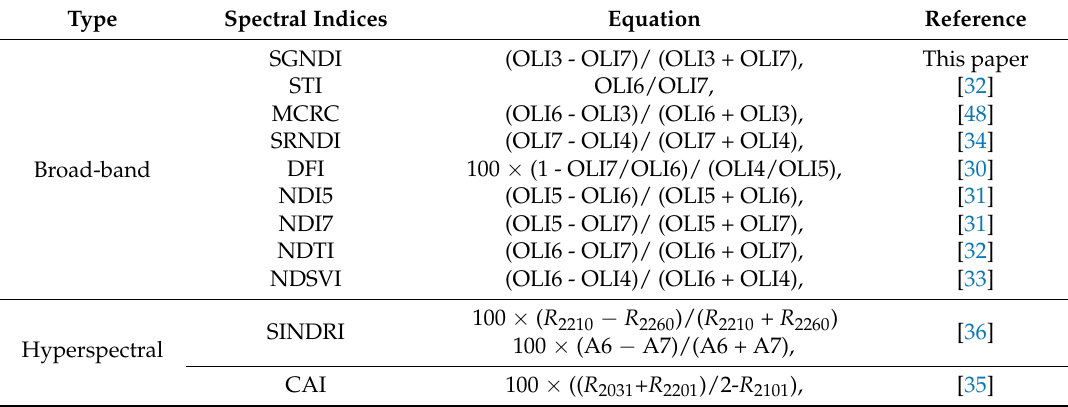
Table 1. Spectral indices used in previous research for estimating crop residue